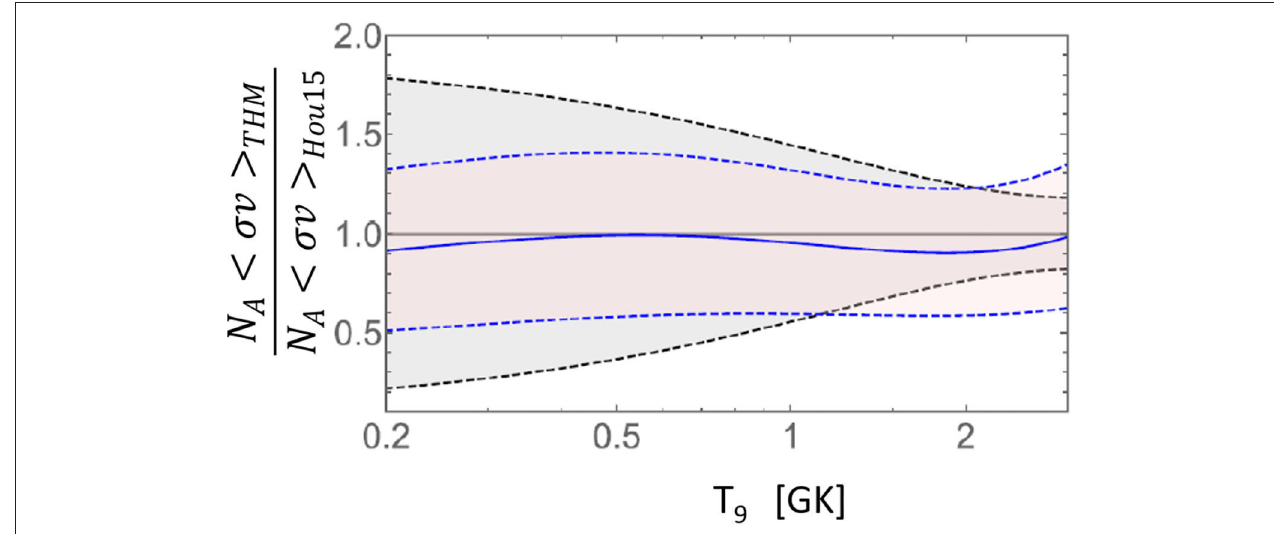
FIGURE 5 | Ratio of indirect (Lamia et al., 2019) on the direct (Hou et al., 2015) rates for 7 Be(n, α ) 4 He reaction, as a function of T 9 . Rates are in agreement and the uncertainty is reduced thanks to the indirect measurement. The figure is adapted from Lamia et al. (2019).